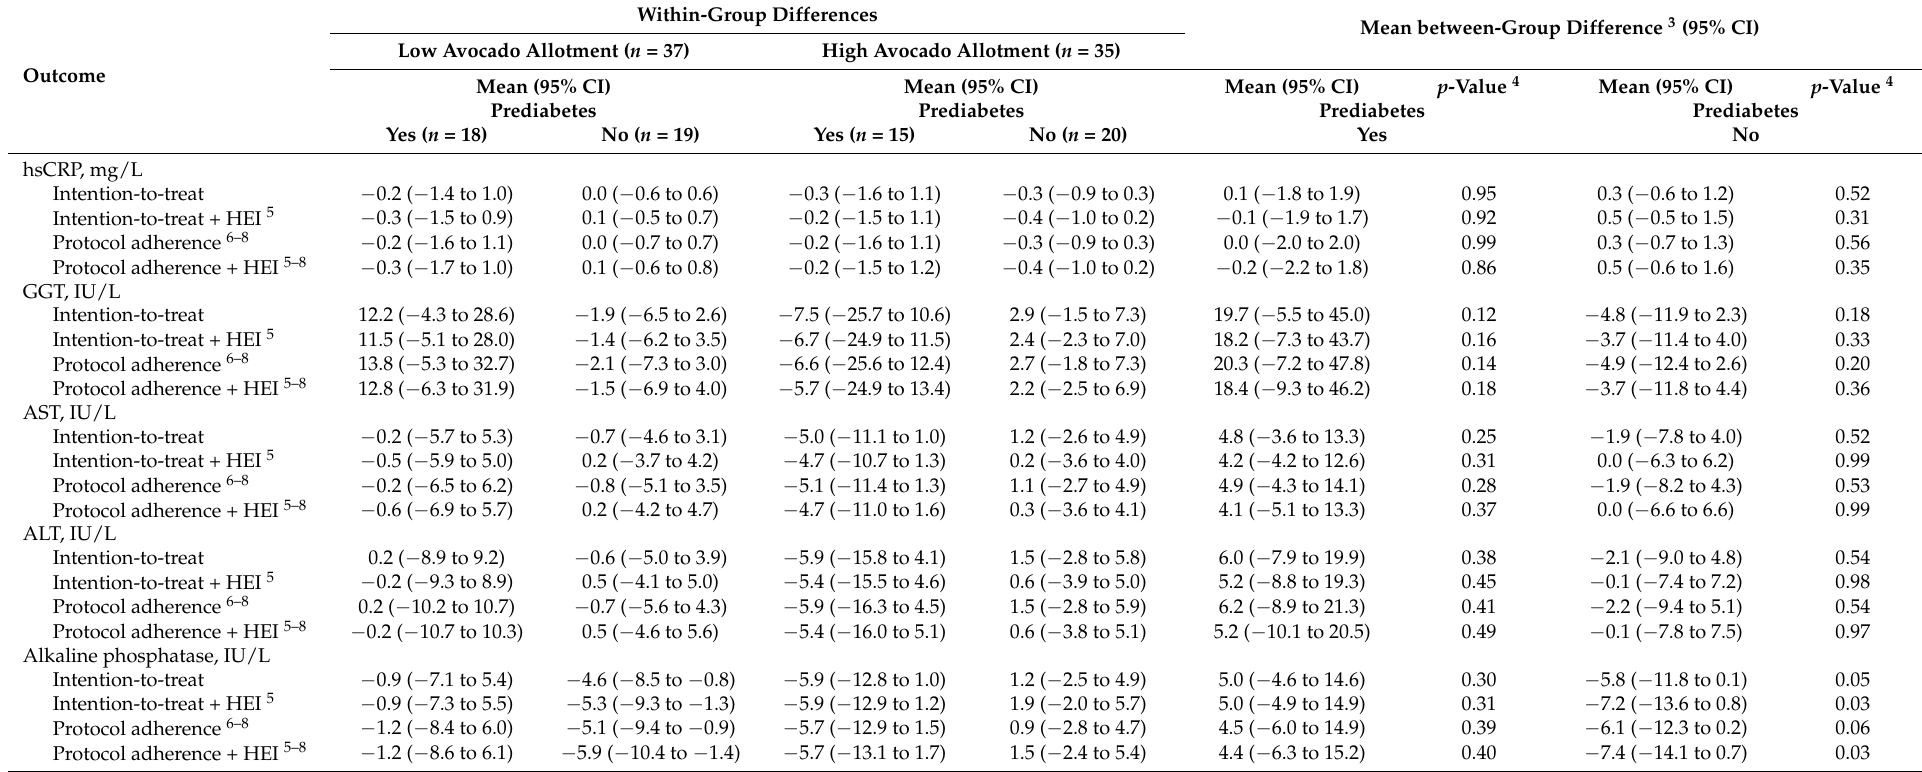
Table 5. Changes in hepatic function outcomes at 6 months after accounting for change in avocado intake 1 , stratified by prediabetes status 2 , per intention-to-treat and protocol adherence